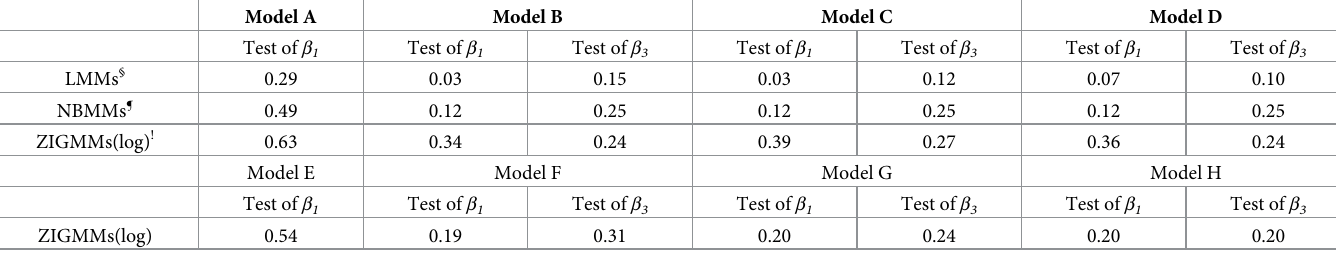
Table 4. Proportions of significant taxa detected in four models with LMMs, NBMMs and ZIGMMs.